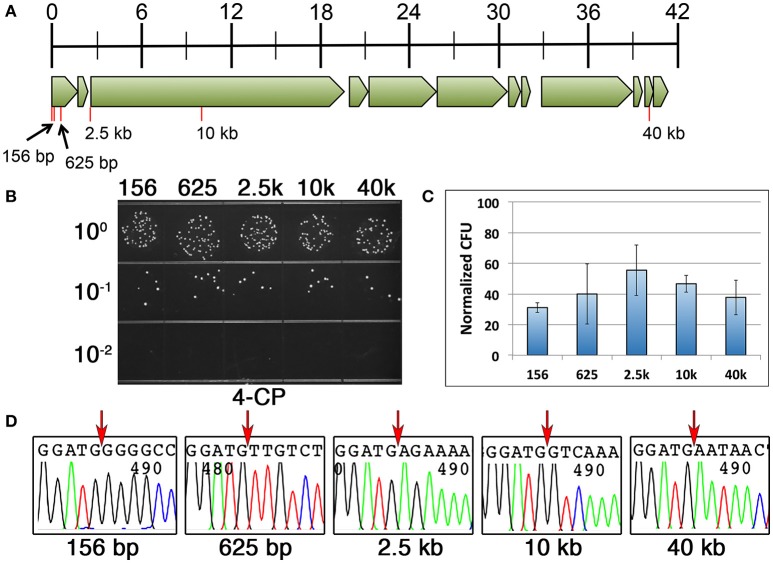
Influence of deletion size upon markerless mutagenesis efficiency. (A) Genomic map of the UA140 mutanobactin gene locus (Wu et al., 2010). Open reading frames are drawn to scale and tick marks in the scale bar indicate size in kb. Red lines indicate the locations and sizes of the different deletions. All deletions start immediately after the translation start codon of the first open reading frame in the mutanobactin locus (mubK). (B) 100 bp direct repeats were used for markerless deletions in the mutanobactin locus. Deletions ranged in size from 156 to 40 kb, as indicated above the image. Shown here are the results obtained from the final 4-CP selection step. (C) The number of markerless mutant clones obtained from each of the deletion constructs was compared. The data are presented as the means ± standard deviations from three independent experiments. None of the means exhibited statistically significant differences as determined by unpaired two-tailed t-tests. (D) Multiple markerless deletion mutant clones were sequenced to assess deletion fidelity. Shown here are representative chromatograms from each unique mutant. Red arrows indicate the locations of the deletions immediately following the start codon of the first open reading frame in the mutanobactin locus (mubK).